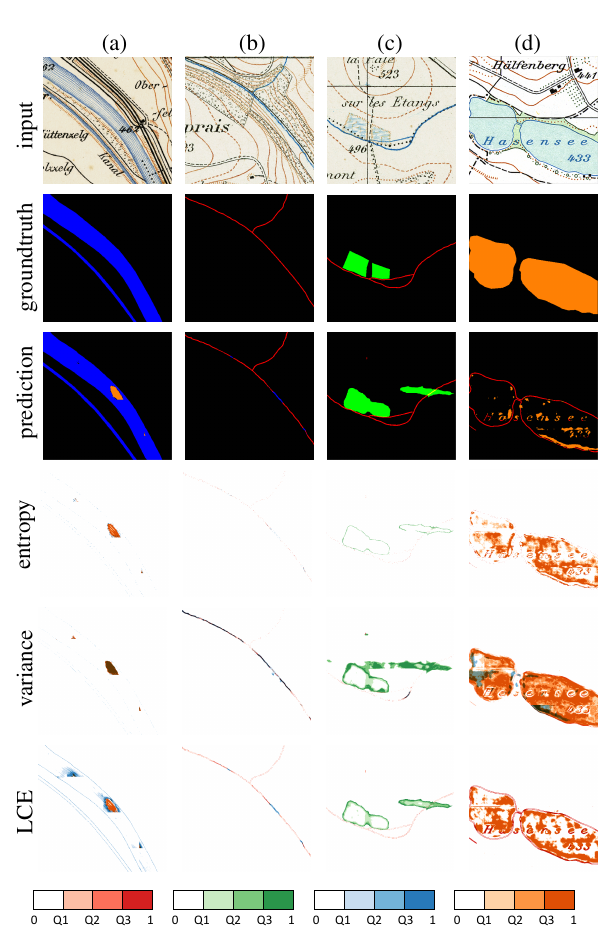
Figure 3. Comparison of different uncertainty indicators. Color bars are presented at the bottom. (a) shows an example where a river is partially misclassified as a lake. (b) and (c) present cases where the prediction accuracy suffers due to noisy strokes (b) for streams and scanning artifacts (c) for wetlands. (d) is an out-of-distribution example where the design varies from the training map sheets.